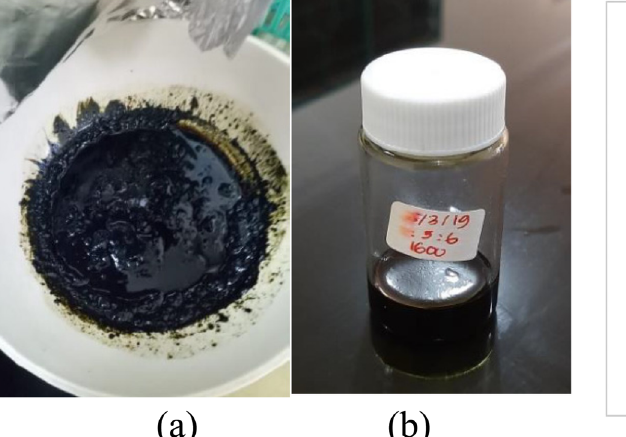
Figure 2: E ff ect of the antihyperglycemic potential of pegagan leaf extract SNEDDS on zebra fi